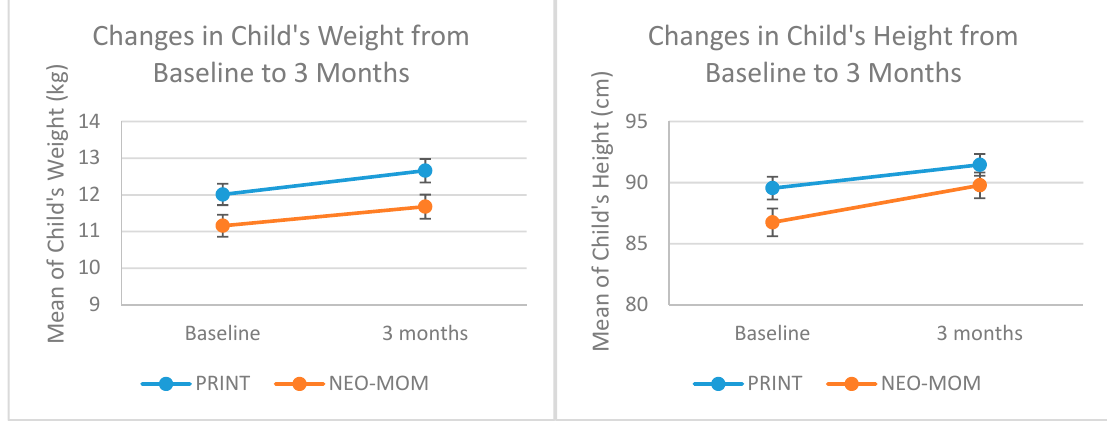
Figure 2 Profile plot of child’s weight and height change from baseline to three months evaluation. Figure 2. Profile plot of child’s weight and height change from baseline to three months